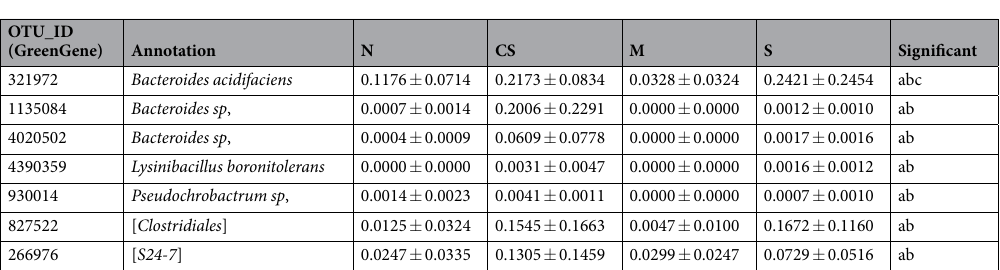
Table 3. Operational Taxonomic Units (OTU) significantly impacted by CS under both healthy and stressed conditions in mice. The numbers denote the relative abundance (mean ± SD). N: healthy mice + PBS; M: mice subjected to exhaustive exercise stress + PBS; CS: healthy mice supplemented with a daily dose of 150 mg/kg bodyweight of CS disaccharides for 16 days. S: the stressed mice supplemented with a daily dose of 150 mg/ kg bodyweight of CS disaccharides for 16 days. Significant means that the abundance of the OTU that was changed at a cutoff value of the absolute log10 LDA scores > 2.0 between the two contrast groups using